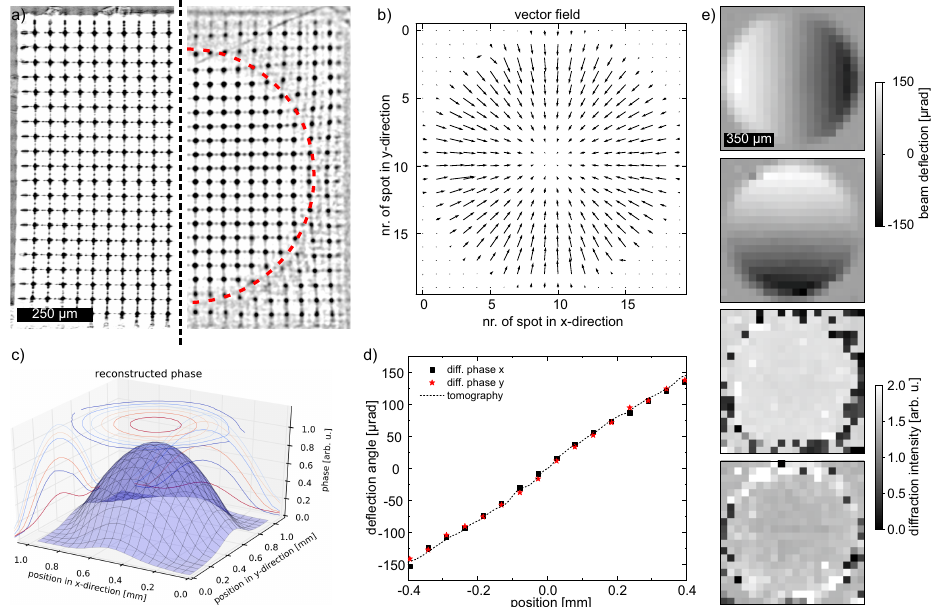
Figure 4. Reconstruction of the phase shift of the beam introduced by a diamond lens. ( a ) shows in the left half the unperturbed beamlet array and in the right half the pattern with diamond lens introduced (rim indicated by red dashed line, intensity inverted and contrasts optimized for better comparison); ( b ) shows the vector field of the spot shifts; ( c ) displays the reconstructed phase shift as surface plot with selected cuts in x , y and z ; ( d ) shows the deflection of X-rays along two orthogonal lines crossing the CRL center (red and black markers) as derived by the Shack-Hartmann setup. A comparison with deflection angles computed based on the real lens shapes as determined by microtomography data (dashed line) is shown; ( e ) shows (from top to bottom) the differential phase (as beam deflection) in x and y -direction and the diffraction in x and